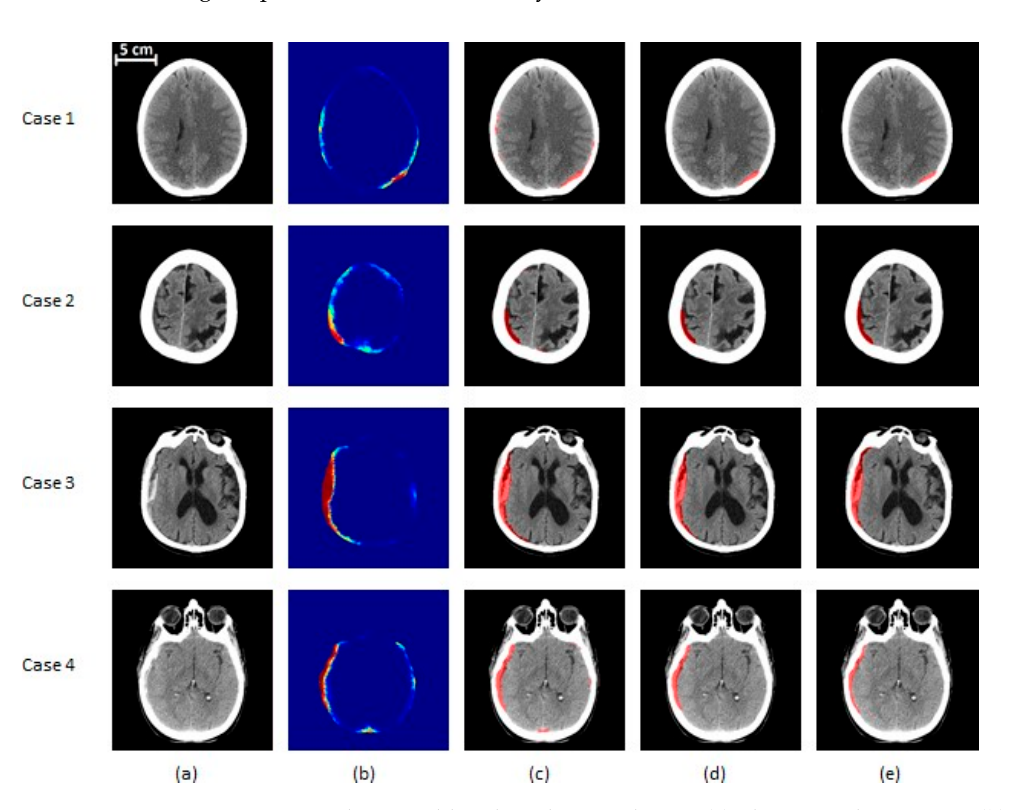
Figure 6. SDH segmentation results on mild and moderate subjects. ( a ) The original CT image, ( b ) the probability map corresponding to the output of the classifier, ( c ) the segmented region before post-processing, ( d ) the segmentation result after post-processing, ( e ) the ground truth. Cases 1 and 2 are mild (<25 cc of blood) patients and cases 3 and 4 are moderate (25–50 cc of blood) ones. Cases 1, 3, and 4 are acute SDH, while case 2 is an example of a chronic hematoma. In ( a , c – e ), the gray region corresponds to brain texture in the original CT image. In ( b ), the colormap ranging from blue to red is associated with probability from zero to one.